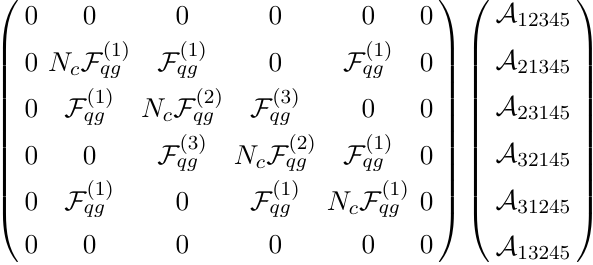
Table 1 . TMD-valued color matrix and vector of partial amplitudes for the processes g (cid:3) q 4 (cid:22) q 0 q 0 and g (cid:3) q 2 ! q 4 (cid:22) q 3 q 5 . The 6 partial amplitudes are explicitly labeled with their associated 3 5 1 permutation. The logic in the enumation of the partons is that gluons come (cid:12)rst, and then anti- quarks, where initial-state quarks count as negative-energy antiquarks. For clarity, all 6 partial amplitudes are included, also the non-contributing ones.